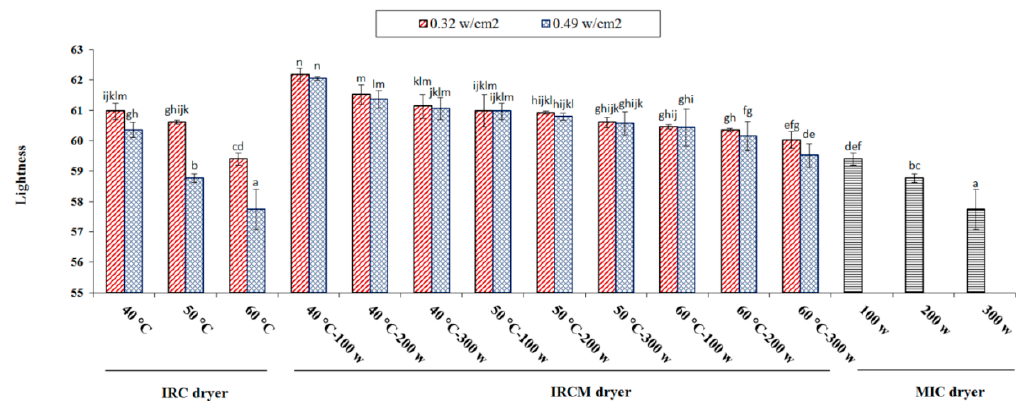
Figure 6. The lightness affected by different drying methods for parboiled rice drying. Note: The same letter over column shows that the mean amount had no significant difference ( p < 0.05) based on Duncan’s test. The error bars represent standard error of the means.